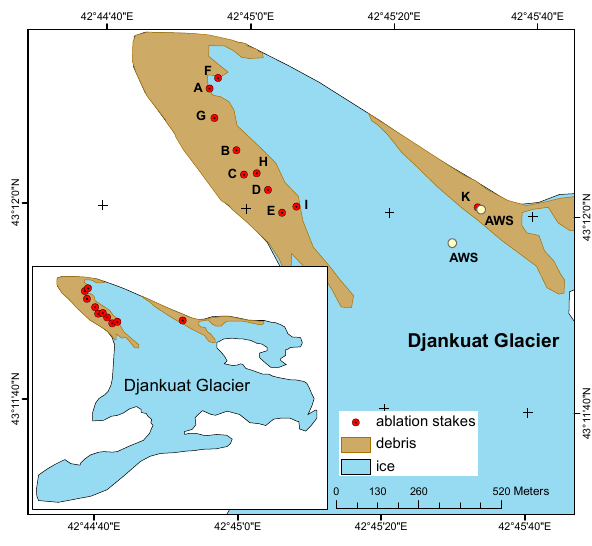
Fig. 3. Overview of Djankuat glacier including the mapped debris cover, the position of the ablation stakes and the automatic weather stations